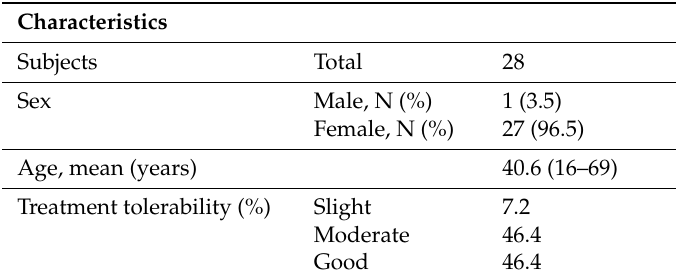
Table 1. Demographic and clinical data at enrollment.